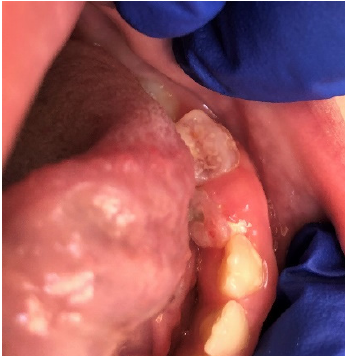
Figure 10. Pyogenic granuloma around 74 and 75 deciduous teeth in a school-aged female. In this case, pyogenic granuloma appears as a smooth, sessile mass with pink-reddish surface. Typically, the mass is painless and bleeds easily. Gingival irritation and inflammation due to poor oral hygiene—similar to this patient—may be a precipitating factor.